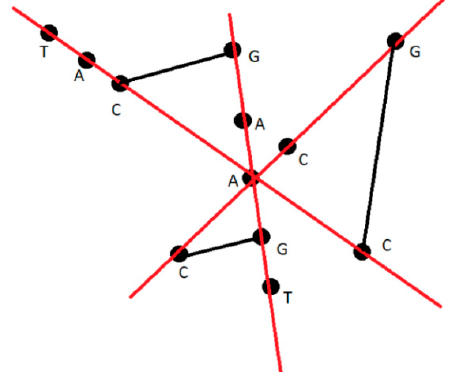
Figure 4. DNA network.